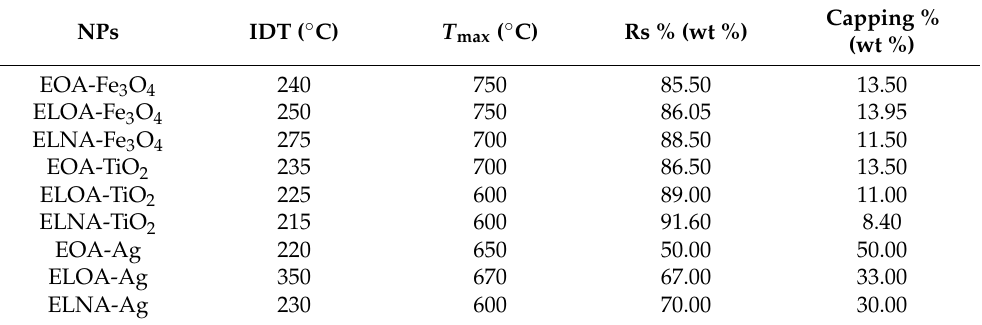
Table 1. Thermal degradation temperatures of capped TiO 2 , Ag and Fe 3 O 4 NPs with EOA, ELOA and